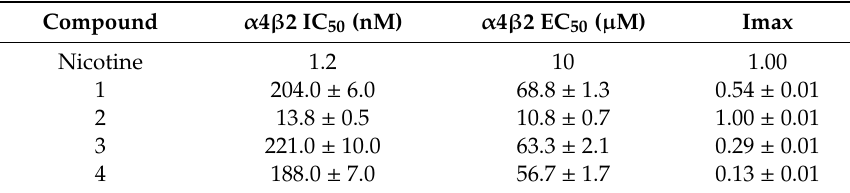
Table 1. Binding affinity (IC 50 ), potency (EC 50 ), and maximal current (Imax) of phenylpyrrolidine derivatives at human α 4 β 2 nAChR. In the case of affinity (IC 50 ) determinations, data represent the